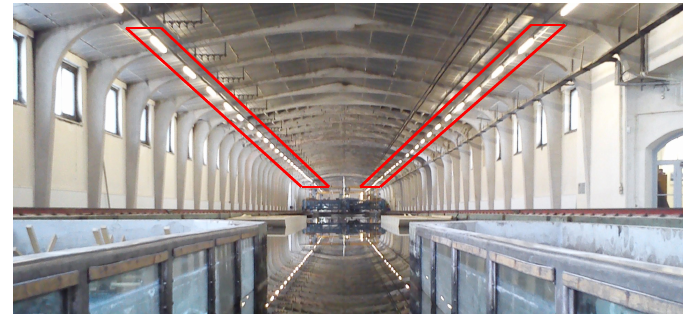
Figure 8. Two arrays of lamps are marked with red bounding boxes. The end points of the single lamps served as the control